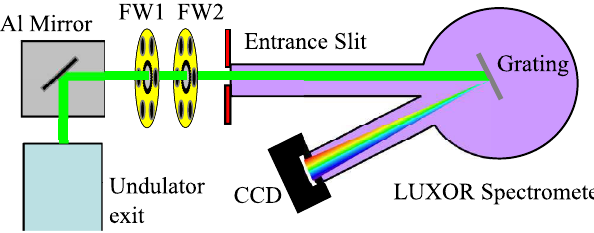
FIG. 7. Layout of the spectrometer and radiation diagnostics at the end of the undulator sequence.